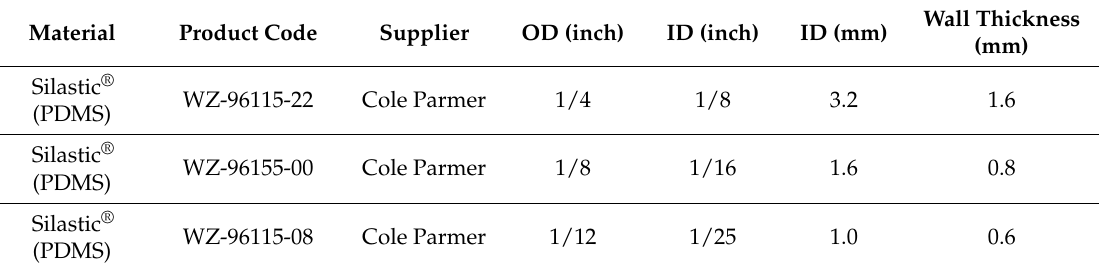
Table 1. Polydimethylsiloxane (PDMS) tubing used as non-porous membranes. OD: outer diameter, ID: inner diameter.